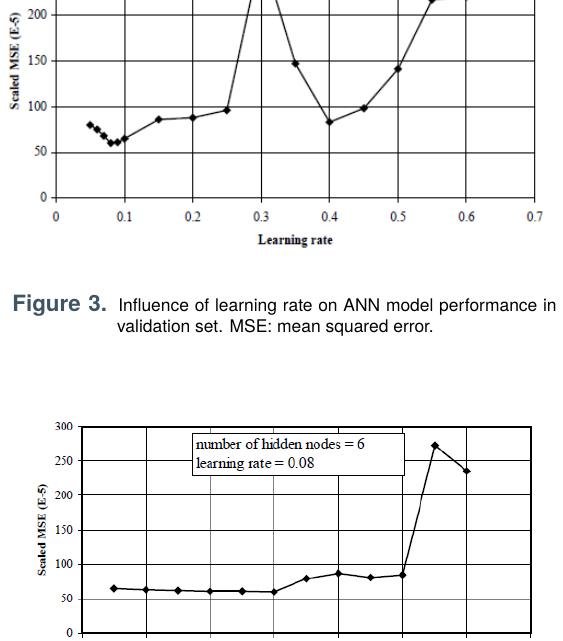
however, the best performance was obtained when mo- mentum term is